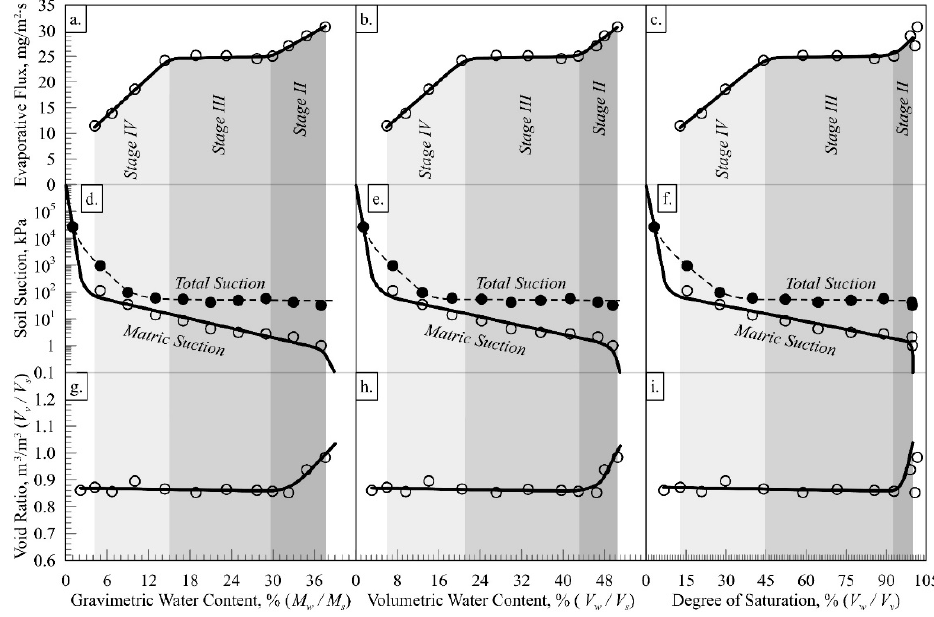
Figure 6. Behavior of silty sand under low atmospheric demand.